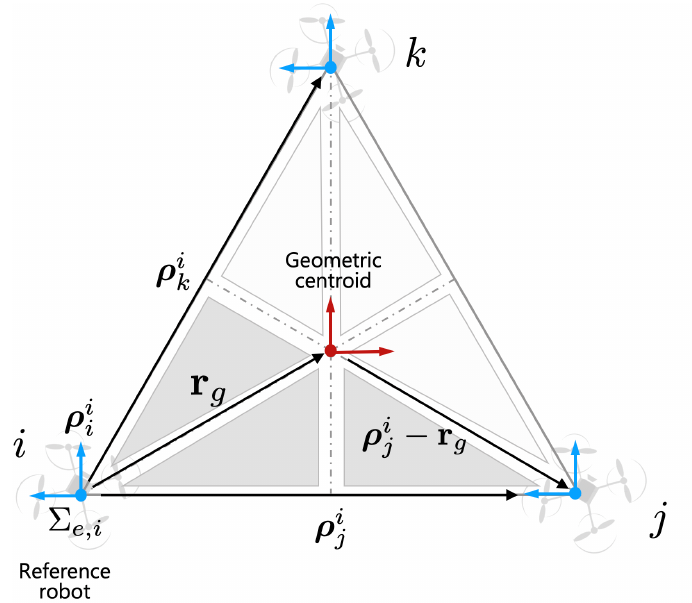
Figure 3. Relative vectors with respect to the reference robot in Σ e , i